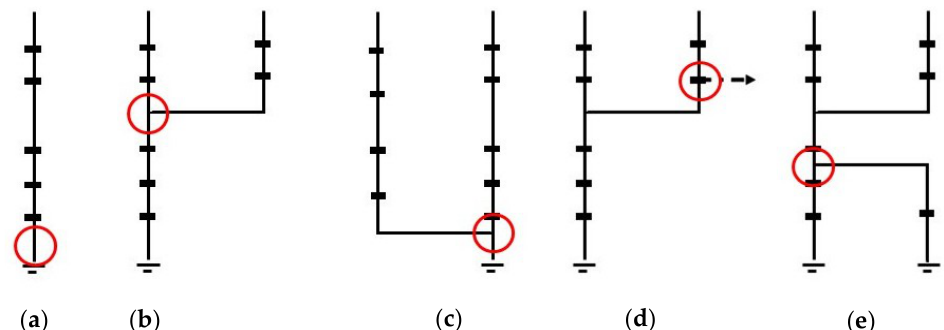
Figure 2. River system type categories in Lombok river basin. ( a ) Single trajectory type; ( b ) Connected trajectory type, tributary with one most downstream node on the main river; ( c ) Unconnected trajectory type, the most downstream nodes of the tributary do not connect upstream to the most downstream nodes in the main river; ( d ) Suppletion channel type, river with suppletion channel; ( e ) Double estuary type, river with double estuary. The red circle is a type of category.